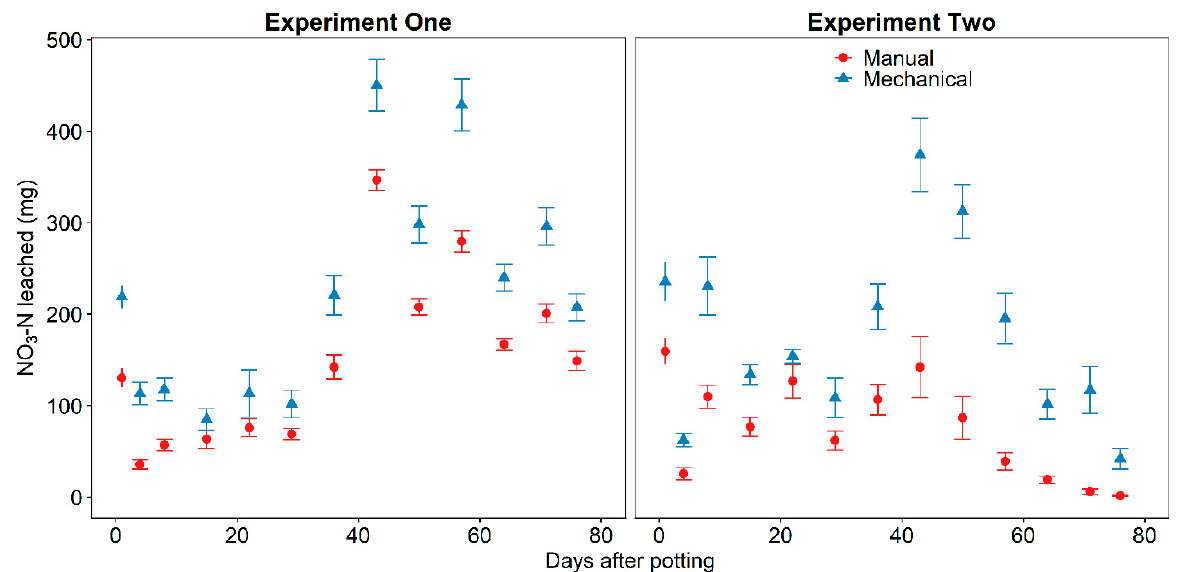
Figure 5. Ammonium-nitrogen leached from unplanted (Experiment One) or planted (Experiment Two) Douglas fir bark substrate and with either manually or mechanically incorporated Osmocote Plus 15-9-12 controlled-release fertilizer. Error bars are standard error ( n = 10) of the mean.